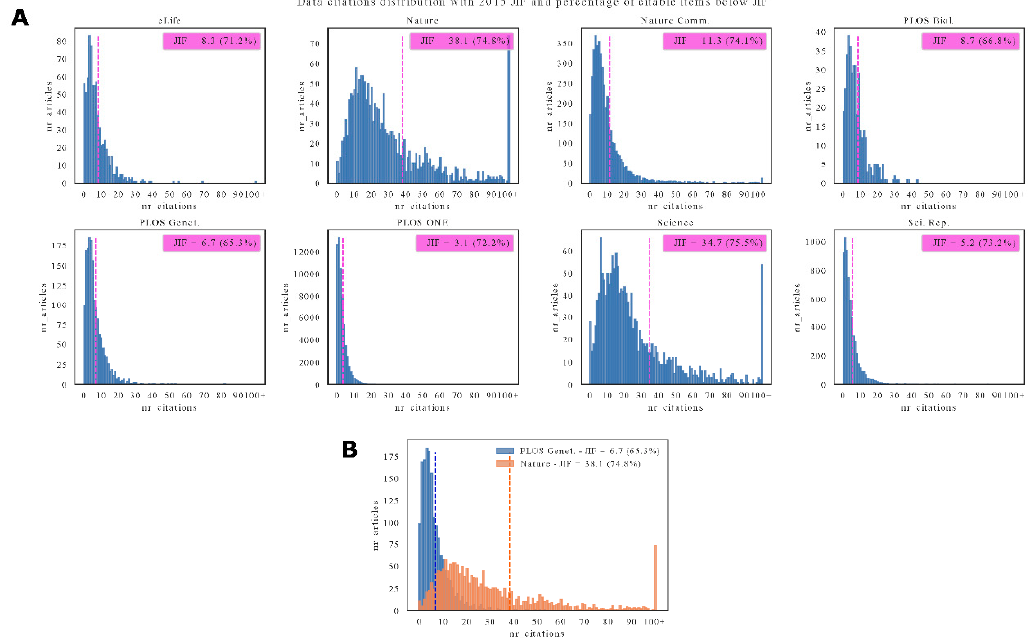
Figure 2. ( A ) Data citations distribution for eight selected journals. Each plot reports the 2015 journal impact factor (JIF) and the percentage of citable items below the JIF (between parenthesis). Data from